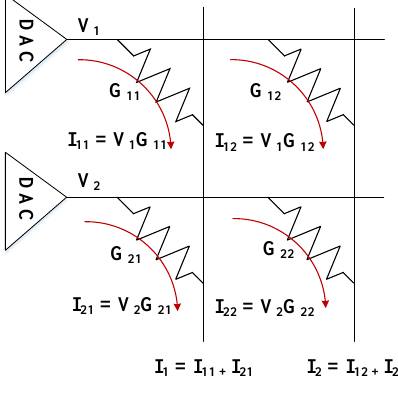
Figure 8. Analog dot-product operation using